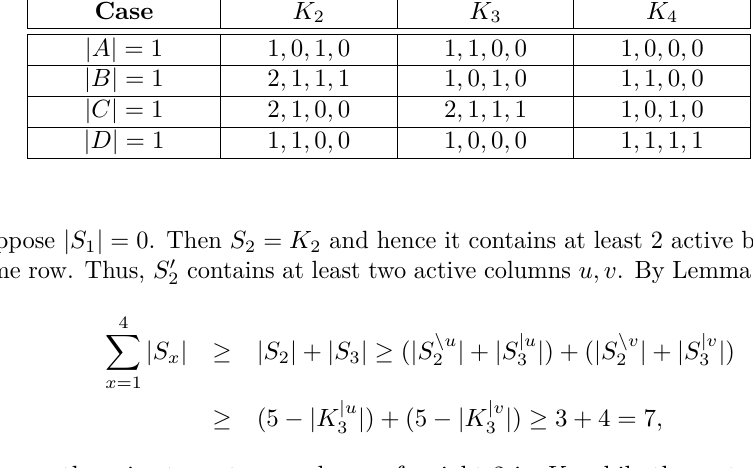
Table 2: Number of active bytes in every column of K 2 , K 3 , K 4 when we have a single active byte in A or B or C or D